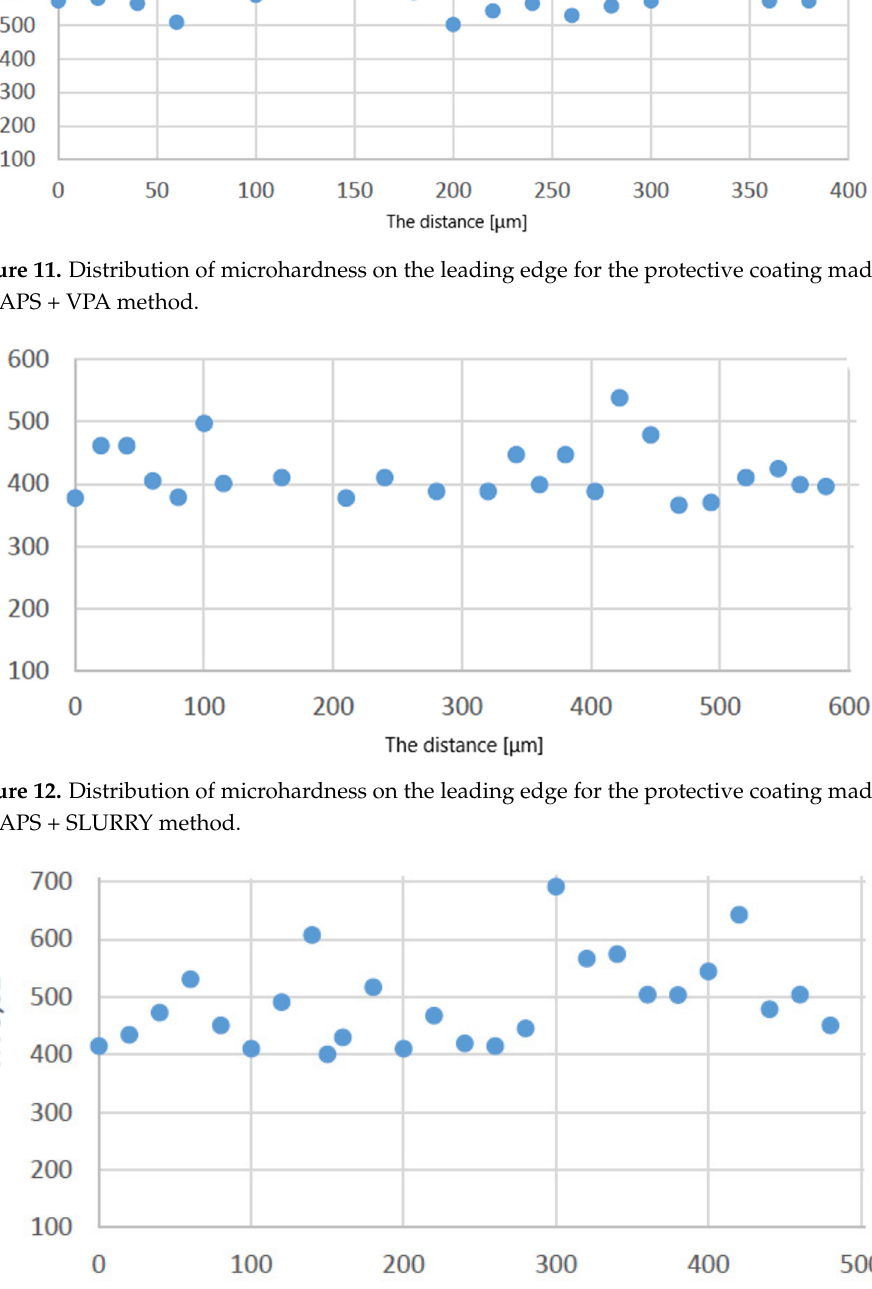
Figure 13. Distribution of microhardness on the leading edge for the protective coating made using the APS + TBC method.